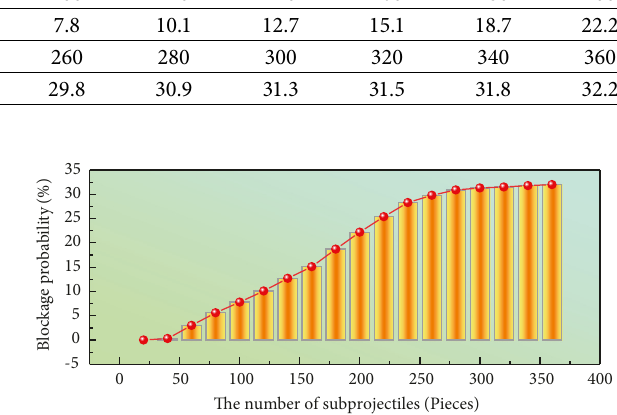
Figure 15: Influence of the number of subprojectiles on the blockage